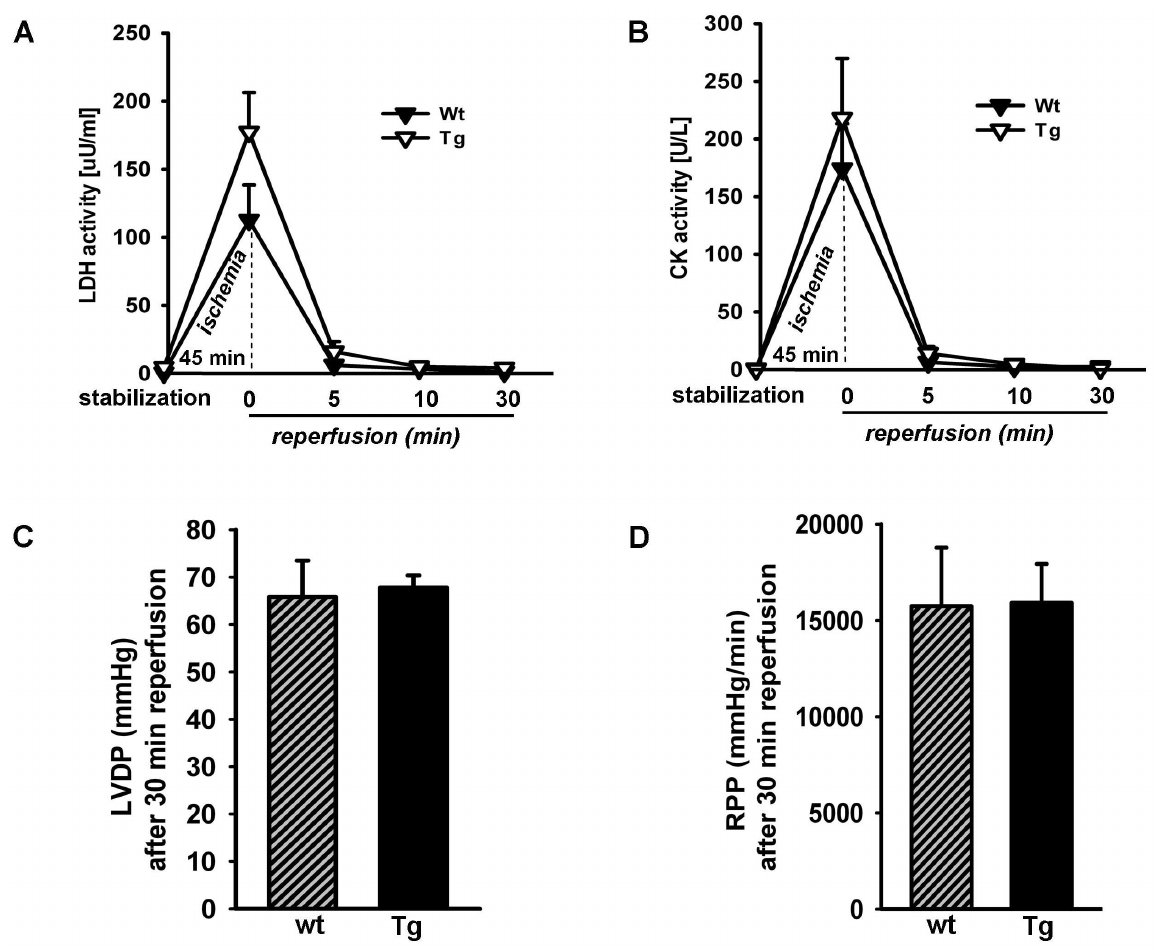
Figure 4. Assessment of ex vivo ischemia reperfusion injury by Langendorff isolated heart perfusion in (P)RR Tg mice. A) Leakage of lactate dehydrogenase (LDH) before and after ischemia and 5, 10 and 30 min after reperfusion of Wt and Tg mice. No significant difference was found between Wt and Tg mice. B) Leakage of creatine kinase (CK) before and after ischemia and 5, 10 and 30 min after reperfusion of Wt and Tg mice. No significant difference was found between Wt and Tg mice. C) Functional recovery; LV developed pressure (LVDP) for Wt and (P)RR Tg hearts after 30 min of reperfusion. D) Rate–pressure product (RPP) for Wt and (P)RR Tg hearts after 30 min of reperfusion. Values are means 6 SEM; n=6 per